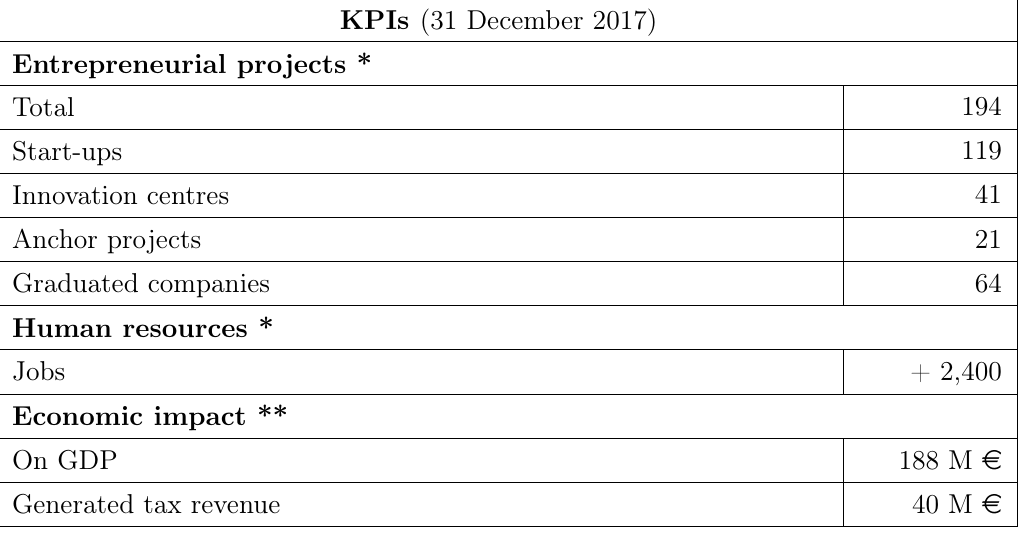
Table 2. UPTEC: Key Performance